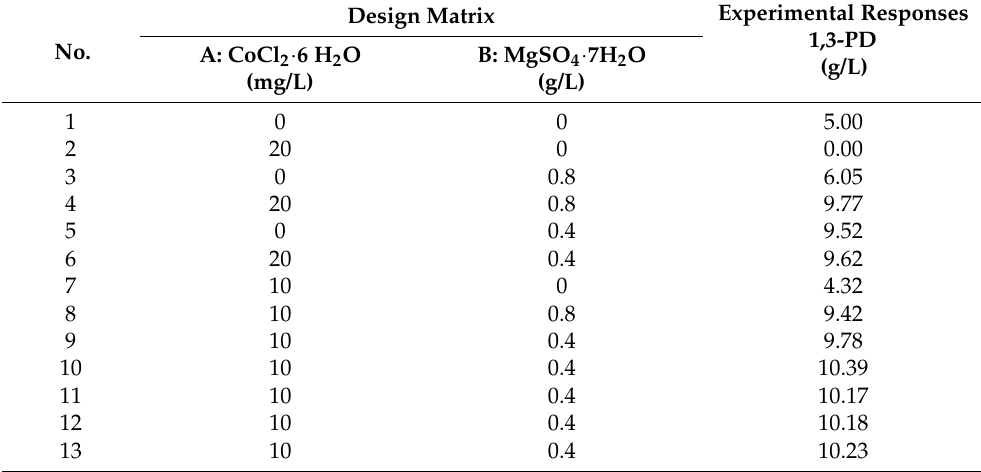
Table 3. Experimental design and experimental results for the central composite design.